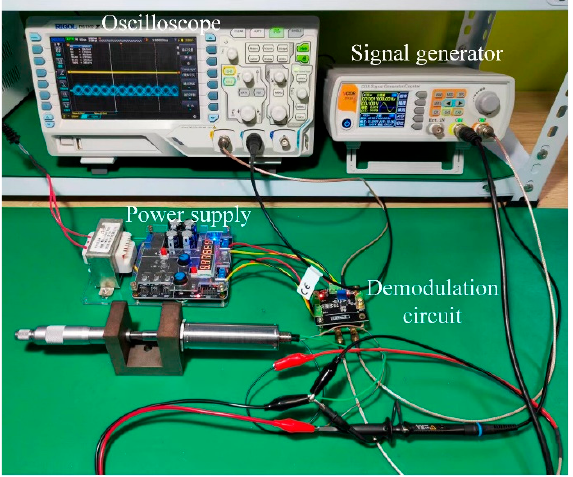
Figure 17. Experimental test.